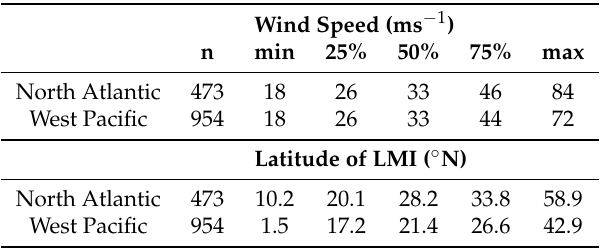
Table 1. TC sample size (n) in the North Atlantic and West Pacific Oceans, along with maximum, minimum, and quartile values of wind speed and LMI latitude.